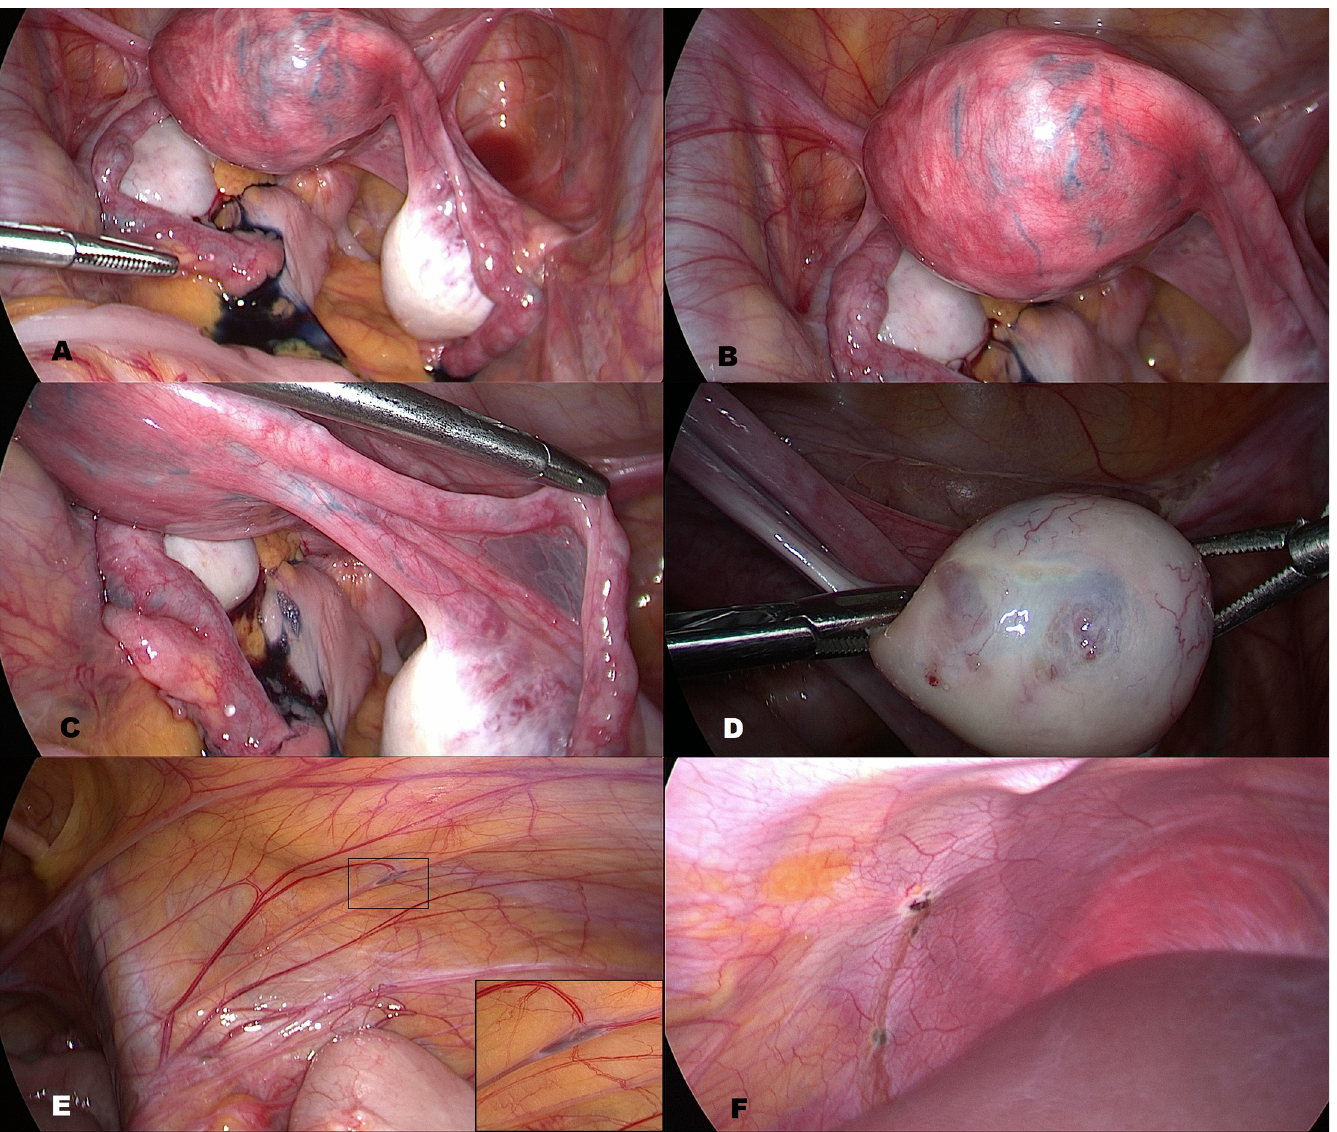
Fig 3. Laparoscopic images. The photo sequence (A to D) shows the methylene blue solution that seeped through the tubes and that permeated the uterine wall (A); after a short while, only sub-perimetrial vessels remained dyed (B) and a few seconds later, a clear staining of the lymphatics surrounding di utero-ovarian artery and vein was evident (C). The dye took some minutes to reach the ovary that showed a faint blue color of the cortex beneath the tunica albuginea (D). Photo E shows an endometriosis lesion within a lymphatic vessel of the lateral abdominal wall (the inset at the lower right corner shows a higher magnification thereof) as demonstrated at immunohistochemistry. Two endometriosis foci deeply invaded the peritoneum that lined the right diaphragm